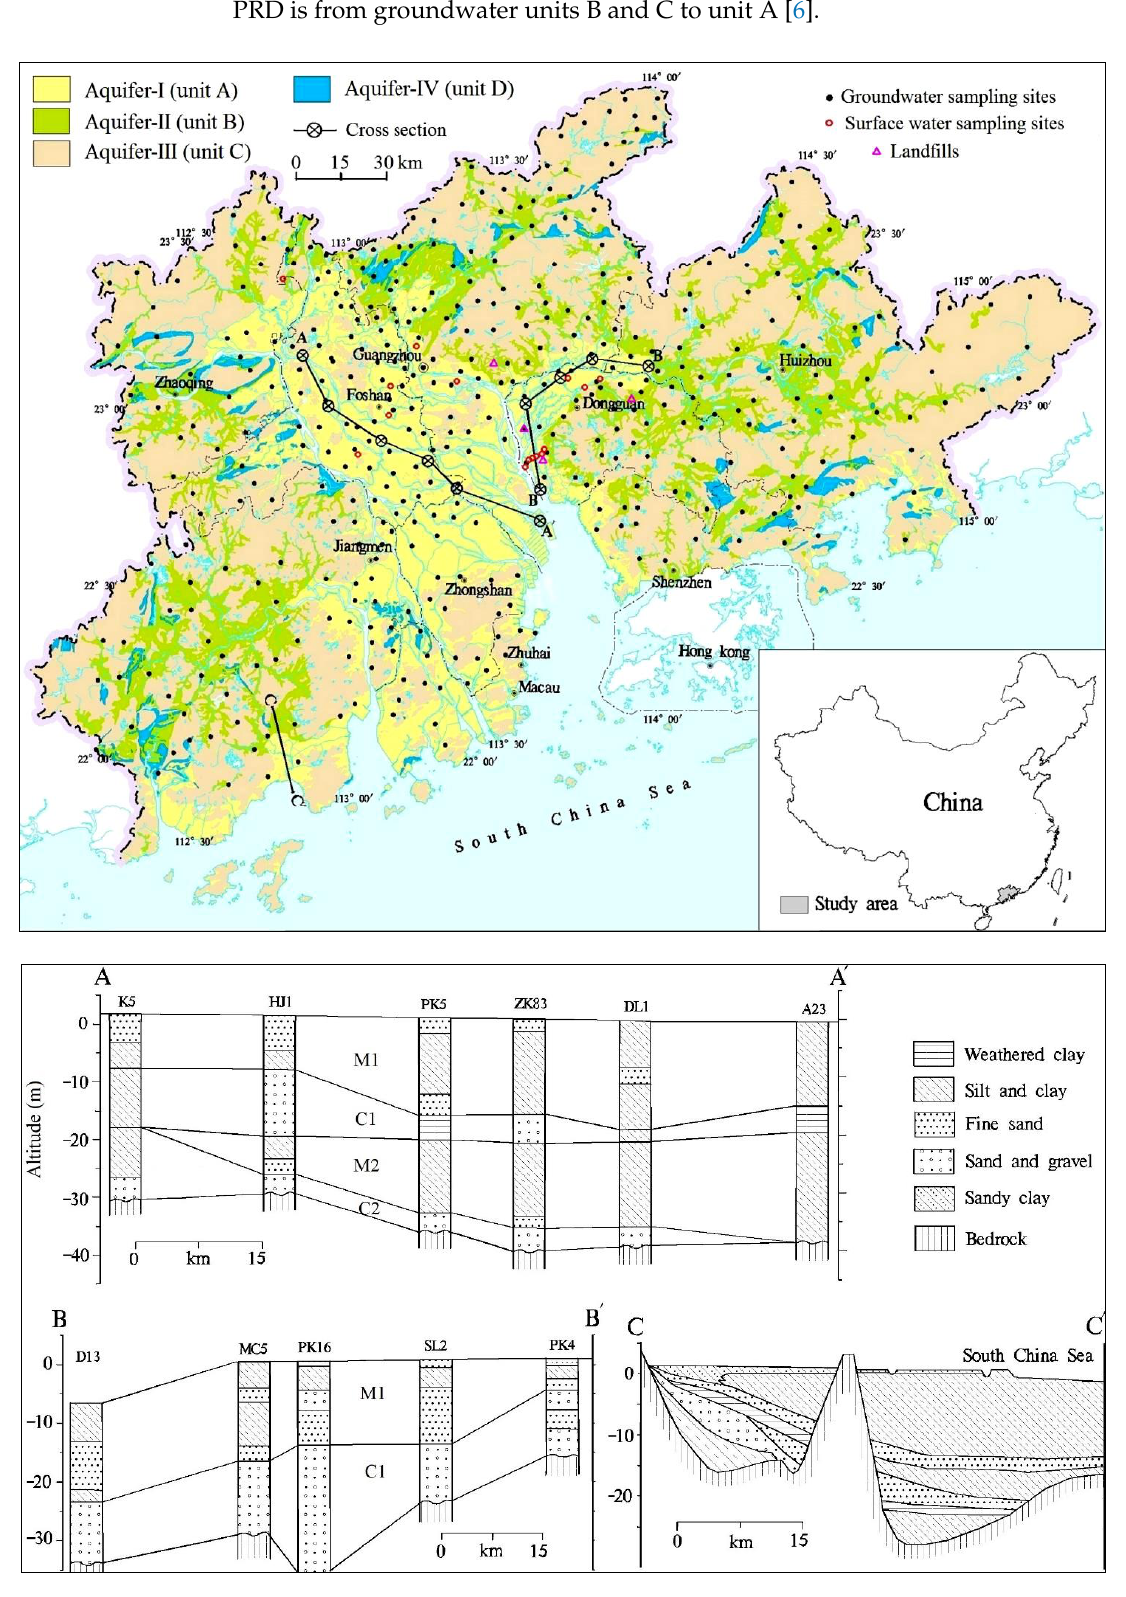
Figure 1. Hydrogeological units and sampling sites in the Pearl River Delta.